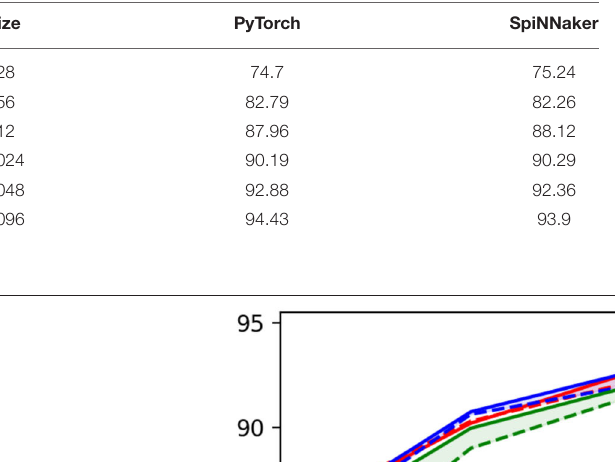
Table 2 . The only work found in the literature that uses LSM for this dataset is Tian et al. (2021). In their work, they report a 90.1% accuracy for a single liquid of size 1,000 and a maximum accuracy